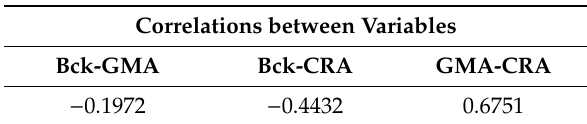
Table 3. Correlation between the three variables background (D1), GMA (Dcx) and CRA (N), using the one-dimensional component of fourth-order cumulant (Equation (7)).